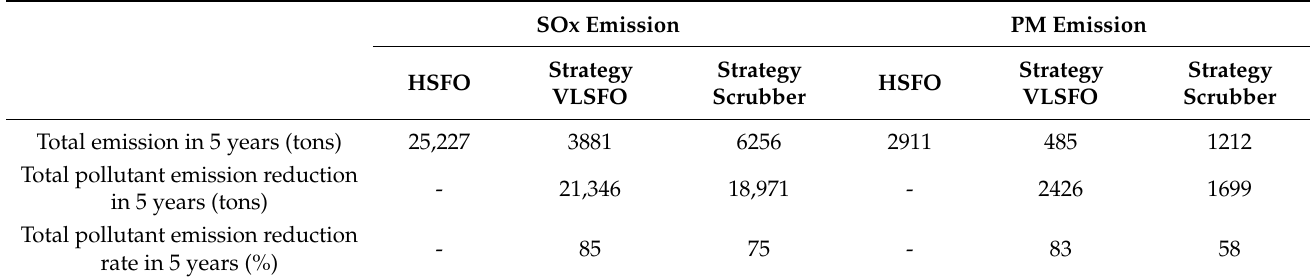
Table 11. Total pollutant emission reduction (tons) and total pollutant emission reduction rate (%) in five years of imple- menting Strategy VLSFO and Strategy